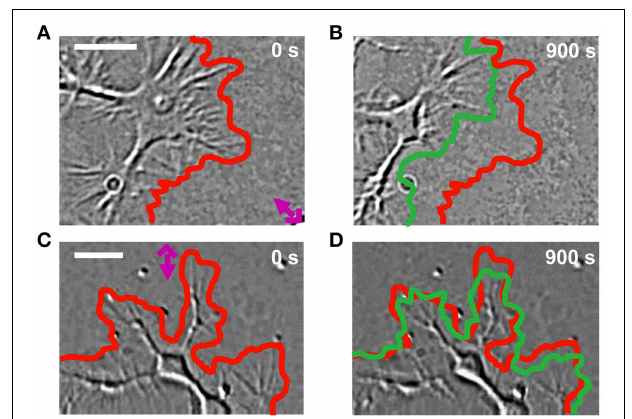
( Figure 3B ; mean FRET ratio of 0.938) ( Figure 3 ). Therefore,